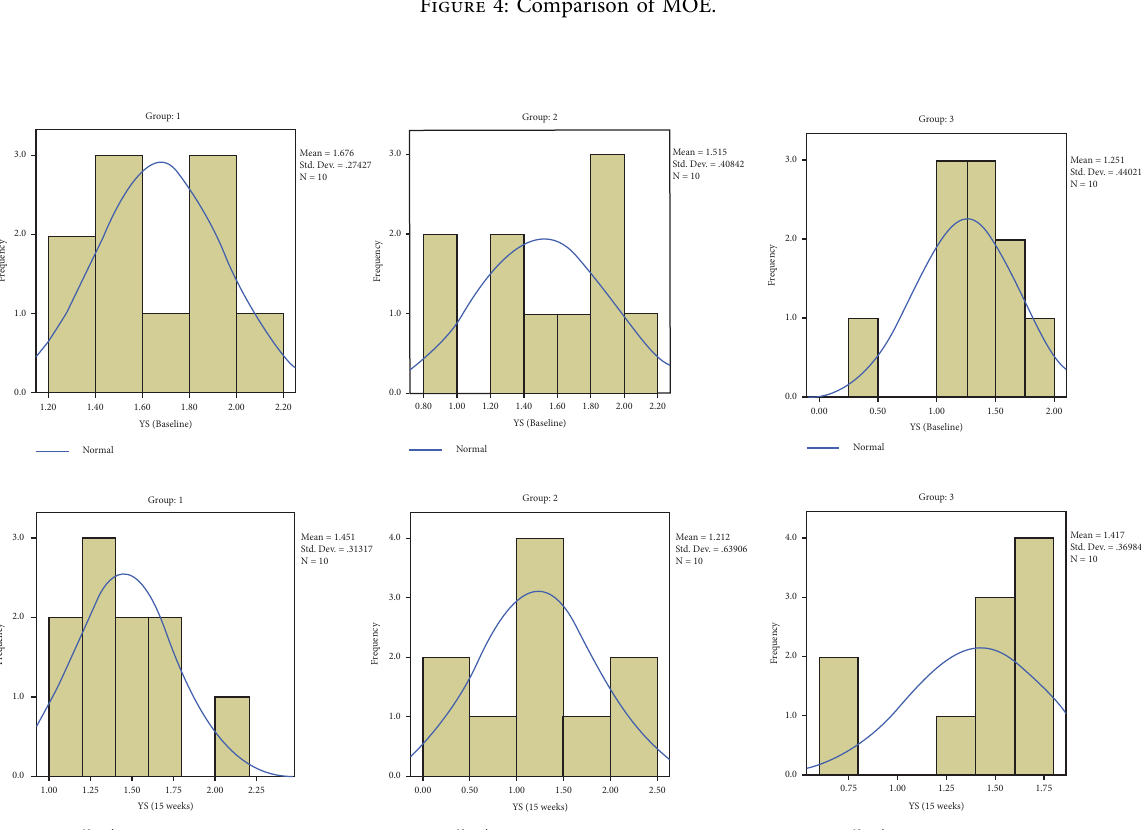
Figure 4: Comparison of MOE.